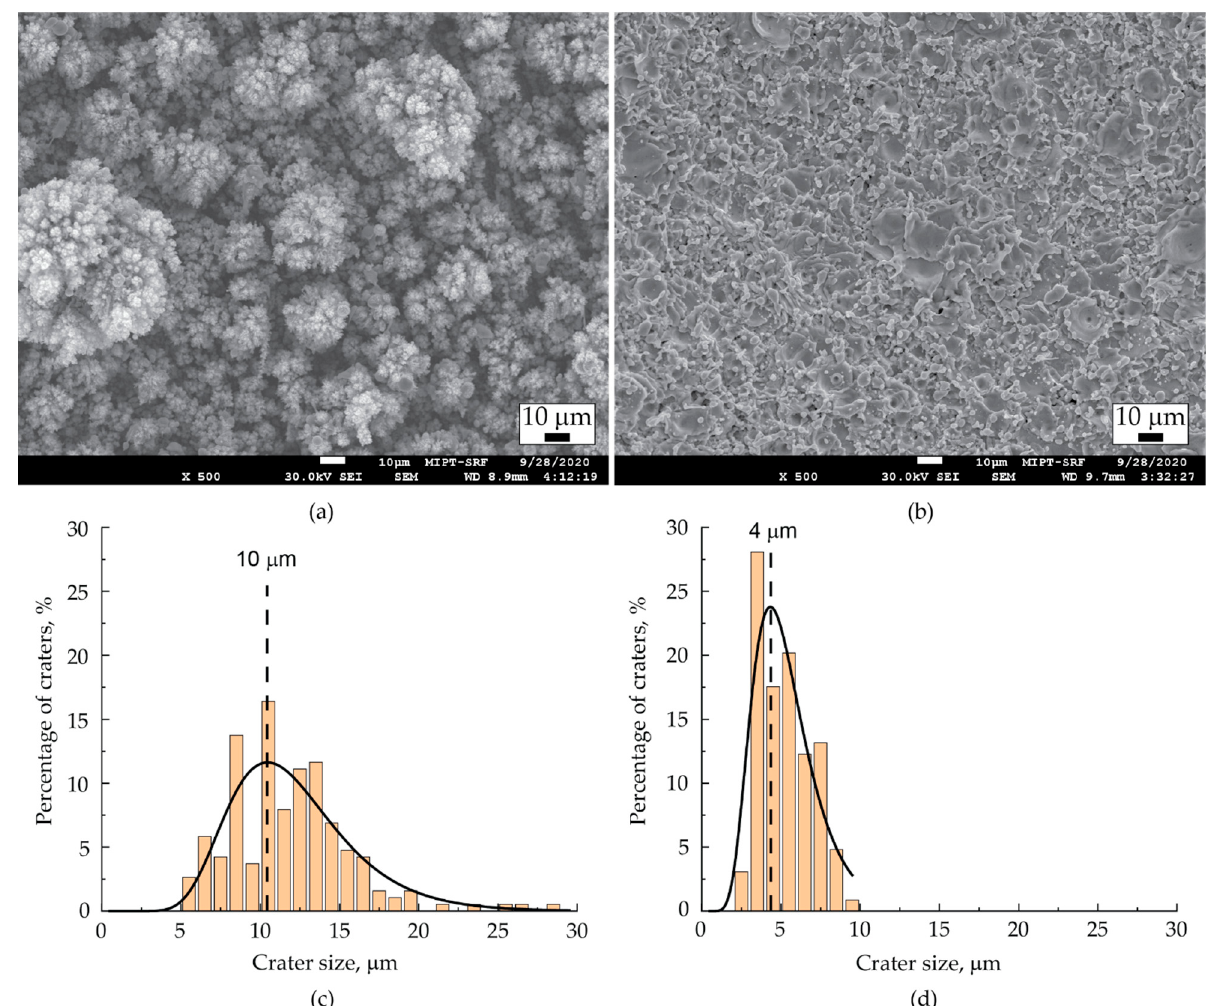
Figure 11. SEM images of typical surfaces of the ( a ) anode and ( b ) cathode after prolonged processing in the SD with the UDP and size distributions of craters on the cathode ( c ) at the area of spark channel location opposite the growing protrusion on the anode and ( d ) at the area aside the spark channel location for the case of the initial parallel arrangement of electrodes’ ends.